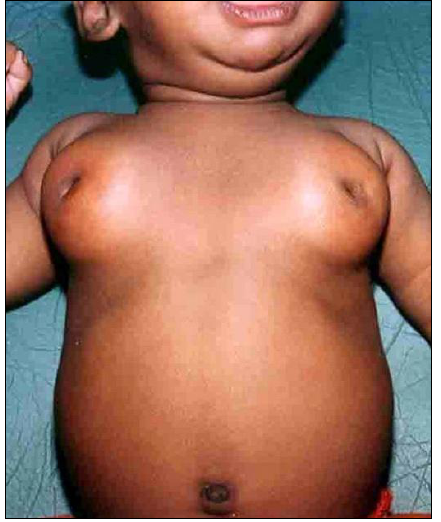
Figure 1: Giant Mastauxe of